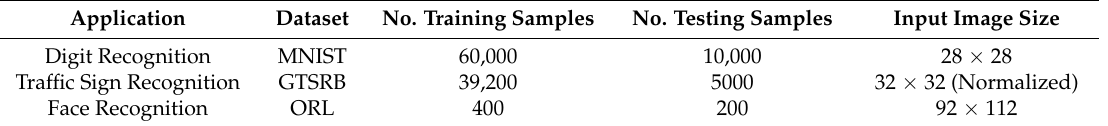
Table 1. Benchmarks used in experiments.